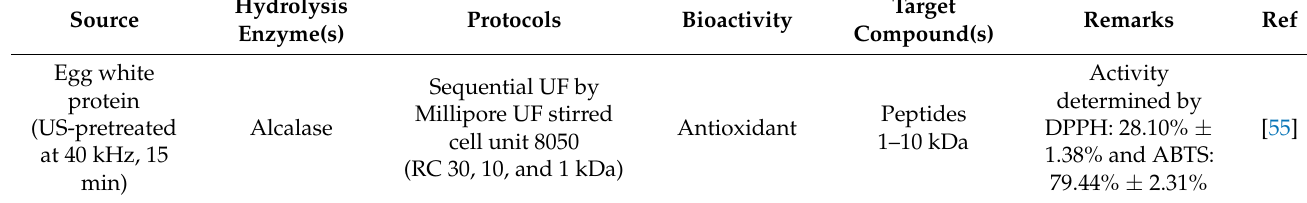
Table 3. Significant UF-assisted separation process of protein hydrolysates with expressed bioactivities from dairy sources.